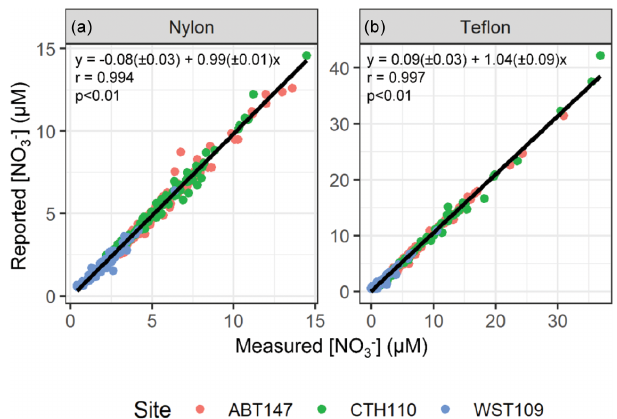
− ) concentrations 3